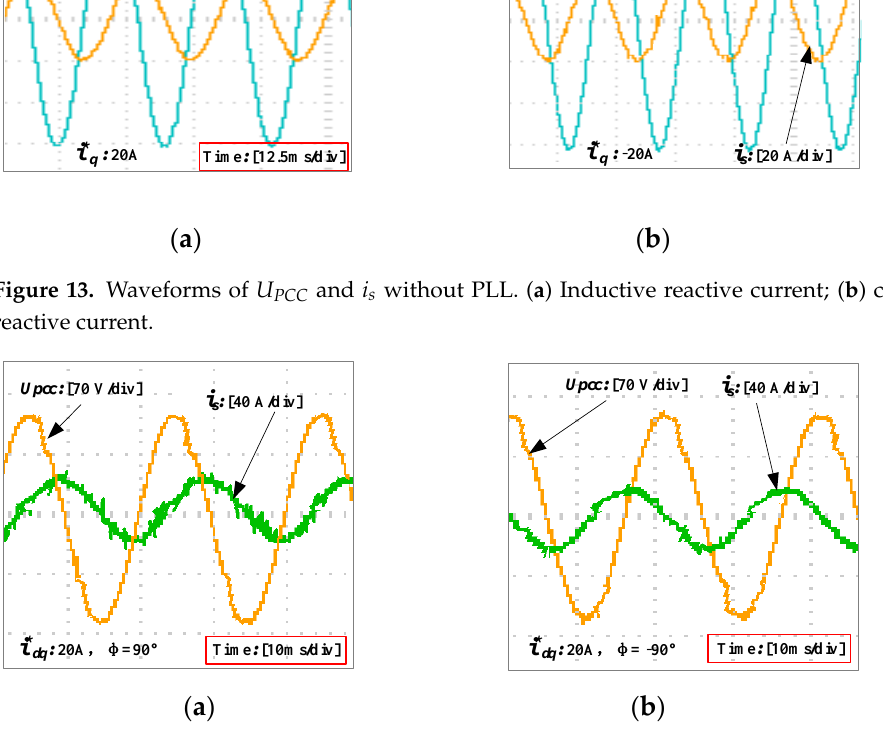
Figure 13. Waveforms of U PCC and i s without PLL. ( a ) Inductive reactive current ; ( b ) capacitive re- active current.